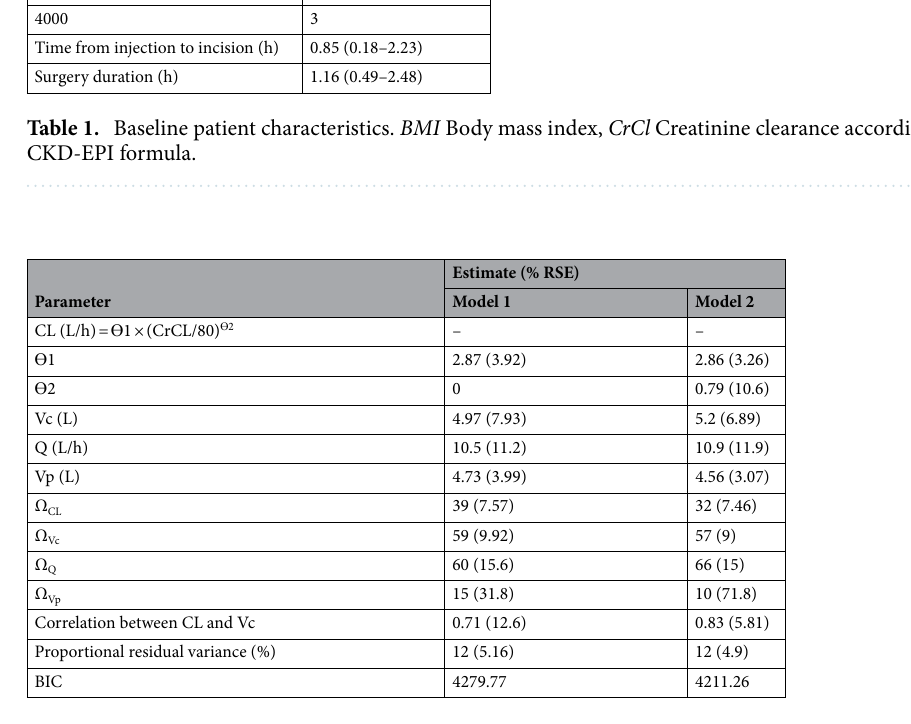
Table 2. Estimates of population parameters for model building. Model 1: model without covariates; model 2: final model including covariates. RSE Relative standard error, CL Clearance, Vc Central volume of distribution, Vp Peripheral volume of distribution, Q Intercompartmental clearance, CrCl Creatinine clearance (mL/min) according to the CKD-EPI formula, Ω Random effect variance for each parameter, BIC Bayesian information